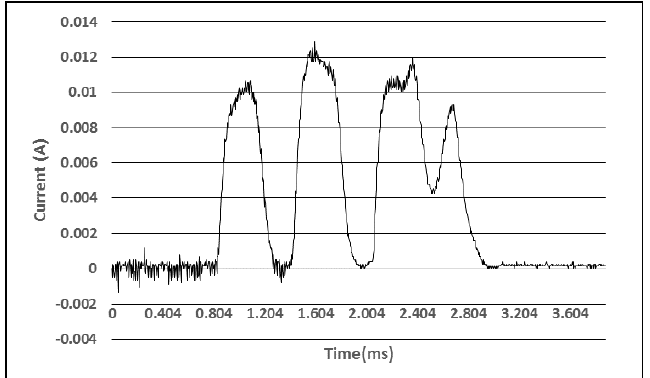
Figure 7. Consumption profile during